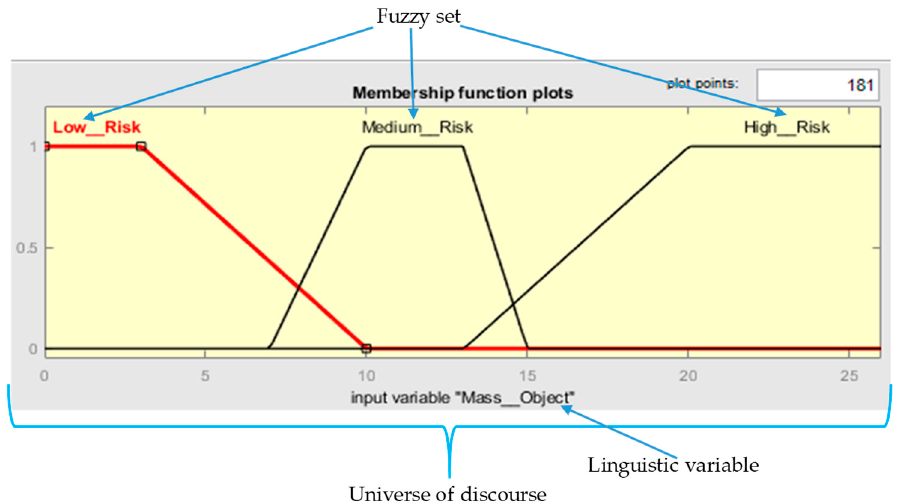
Figure 1. The representation made by the Fuzzy Logic Designer of the universe of discourse, linguistic values, fuzzy sets, and membership function.